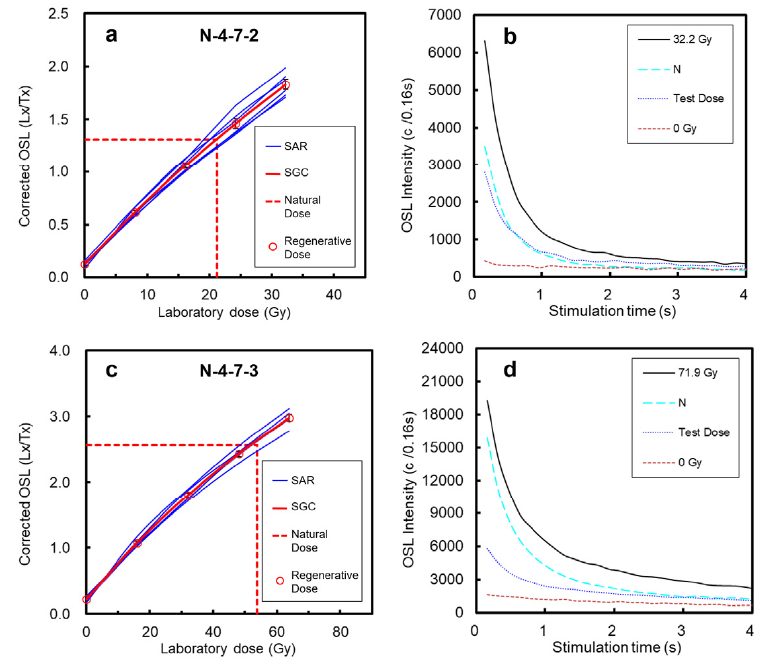
Figure 9. Growth curves ( a , c ) and decay curves ( b , d ) of two representative samples N4-7-2 and N4-7-3.